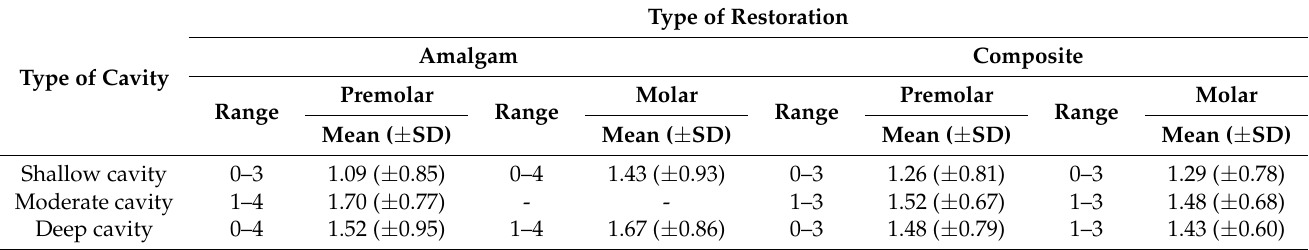
Table 2. The mean number of teeth needed for preclinical simulation laboratory practice ( n = 23). Type of Restoration Amalgam Composite Type of Cavity Range Shallow